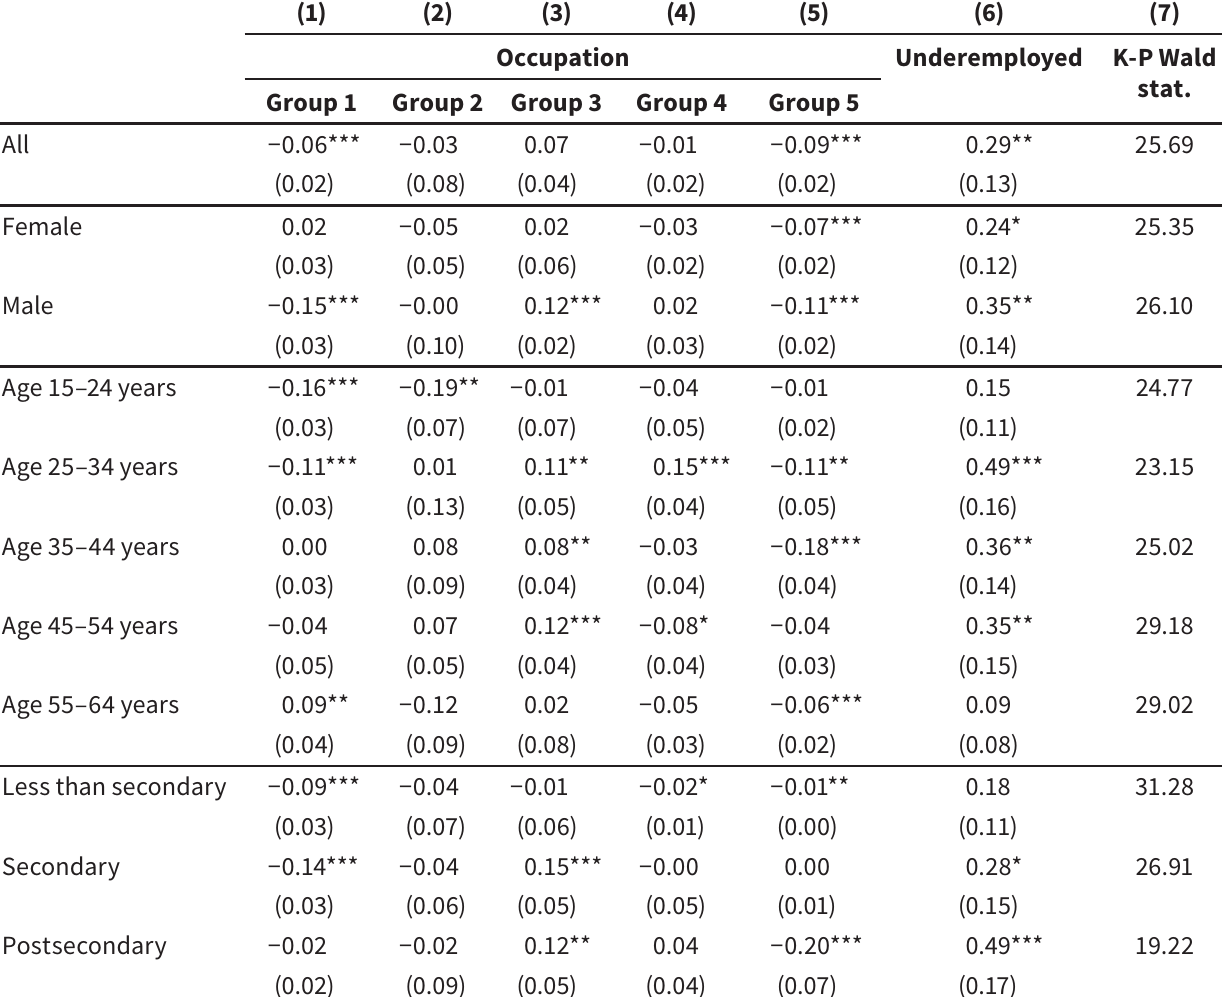
Table 4 2SLS effects on employment by occupation skill